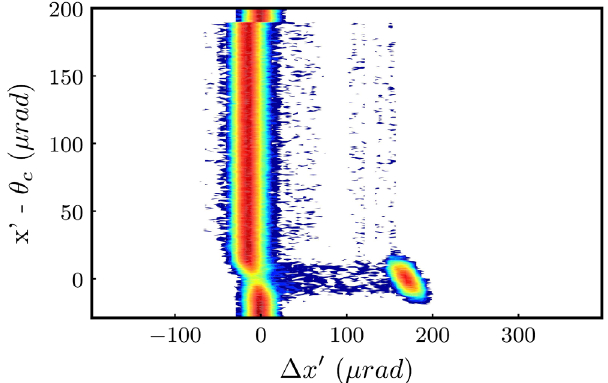
FIG. 7. Rebinned and interpolated crystal scattering response from measurements shown in Fig. 5, as given in input to the tracking simulations.